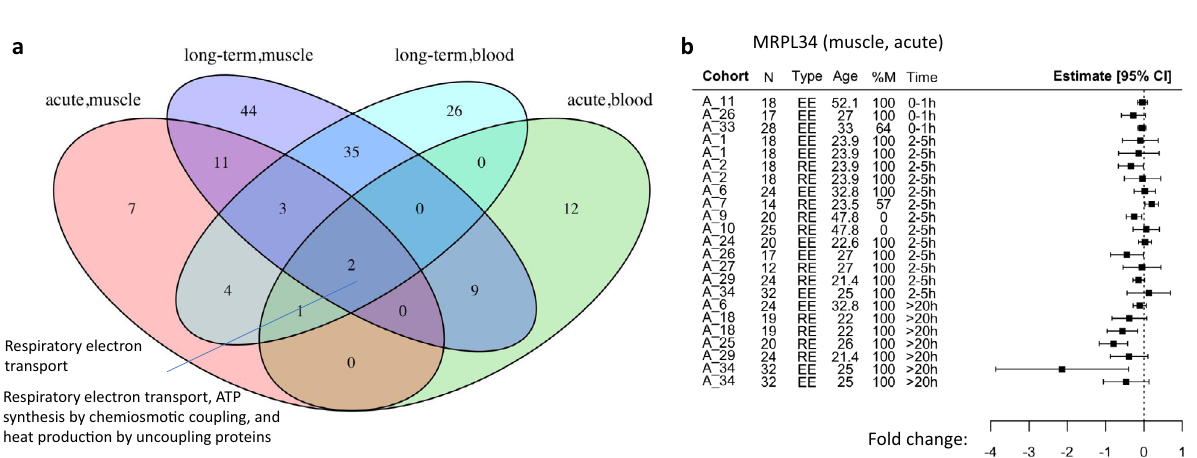
Fig. 2 Random-effects meta-analysis results. a Venn diagram of the signi fi cant GSEA pathway sets discovered with 10% Benjamini – Yekutieli FDR correction. The two common pathways are listed on the left. Pink — acute muscle changes, purple — long-term muscle changes, turquoise — long-term blood changes, green — acute blood changes. b Forest plot of the effect sizes of MRPL34 in acute muscle cohorts illustrates the importance of adding time as a moderator. Rows represent the 95% con fi dence interval of a fold-change of a cohort in a given time point. Thus, in each interval the center represents the fold-change estimate and the error bars are proportional to the fold-change standard error. Downregulation is observed only in time points >20 h. Cohort: the ID given to the cohort in this study (see Supplementary Data 1 for details), N: sample size, Type: exercise type, RE: resistance exercise, EE: endurance exercise, Age: mean age in cohort, %M: percent of males in cohort, Time: the time window in hours. Note that a cohort can have multiple rows with the same time window and different fold-changes (e.g., if a study measured both 2 h and 4 h then both time points will be assigned 2 – 5 h). Source data are provided as a Source Data fi